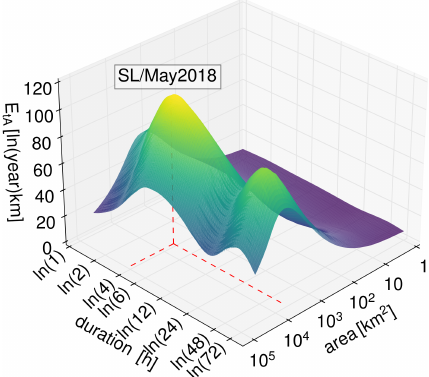
Figure 6. Kleinblittersdorf, Saarland, May 2018 (SL/May2018). Surface defined by E tA curves. The red lines indicate the spatial and temporal scale at which the event reached its maximum ex- tremeness.